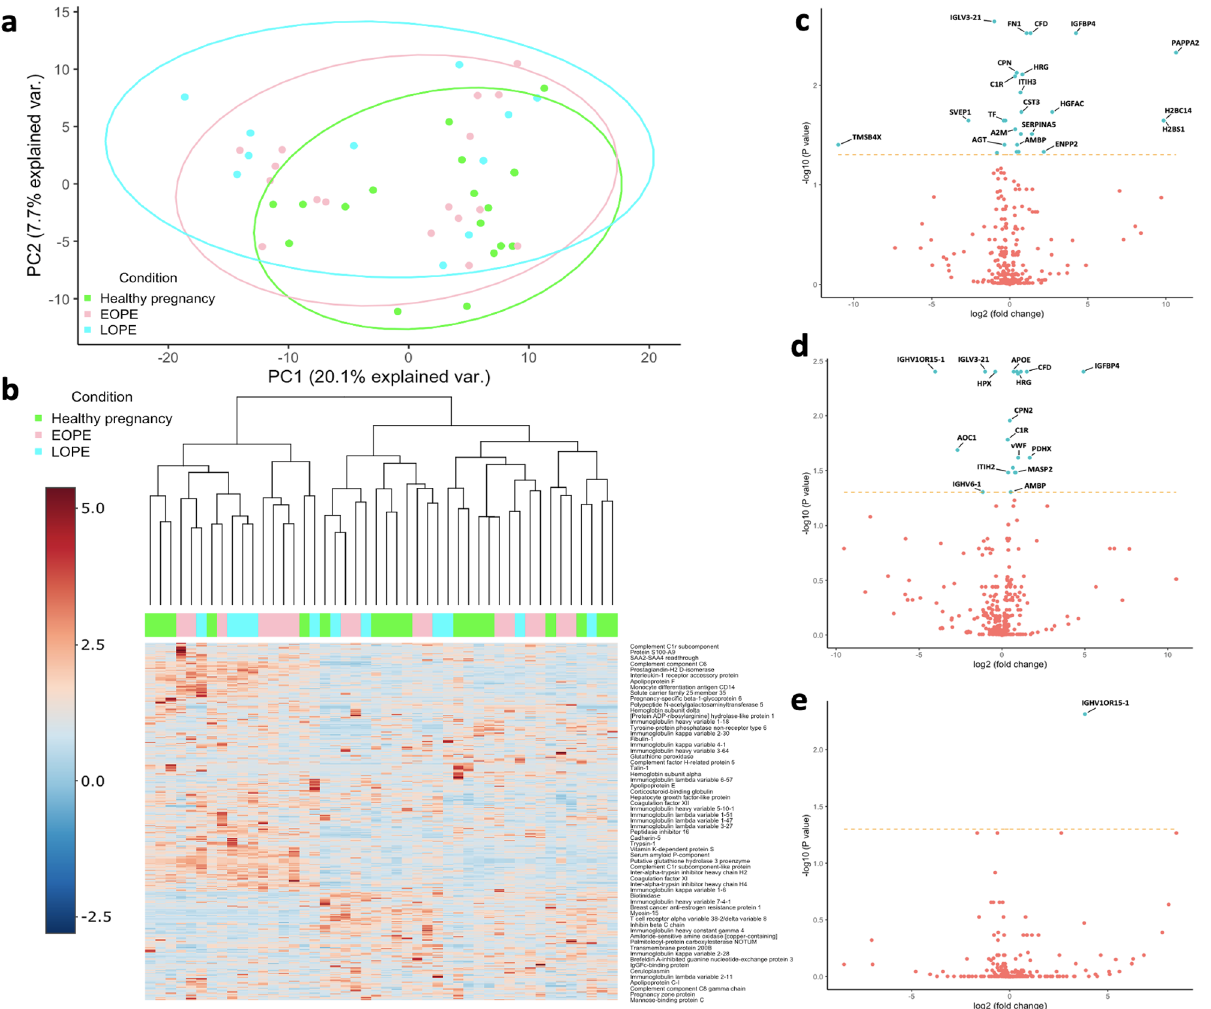
Figure 1. Overviews of differential expression analysis. ( a ) Principal component analysis (PCA) plot of proteomic data in EOPE, LOPE and healthy pregnancy groups. ( b ) Multigroup heatmap with hierarchical clustering dendrogram of proteomic data levels across EOPE, LOPE and healthy pregnancy groups. Volcano plots of proteomic data in ( c ) EOPE versus healthy pregnancy, ( d ) LOPE versus healthy pregnancy, and e EOPE versus LOPE. The differential expression (DE) analysis was performed by fitting a linear regression model adjusted for GA at delivery. DE proteins were defined as Benjamini–Hochberg adjusted P value < 0.05, as indicated by the proteins above the cut-off lines. Source data are provided as a Source Data